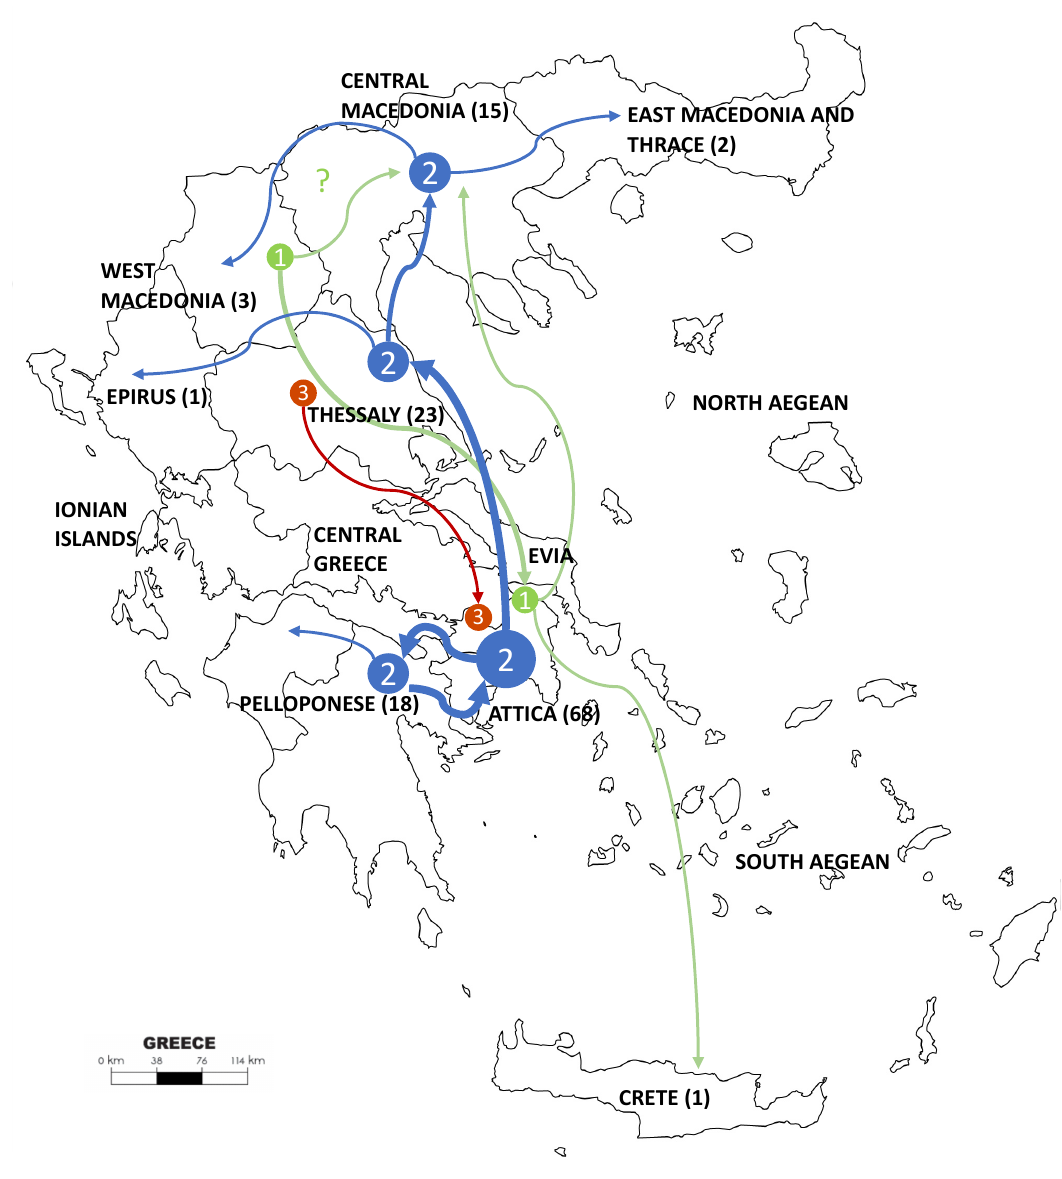
Figure 2. Geographic representation of the three main measles virus (MeV) clusters’ dispersal across Greece during the 2017–2018 outbreak. Colored arrows and numbers are in accordance with Figure 1 and Figure 3A. The flow is based on locations of samples isolation across time. The number of sampled sequences from each province is presented in parentheses.